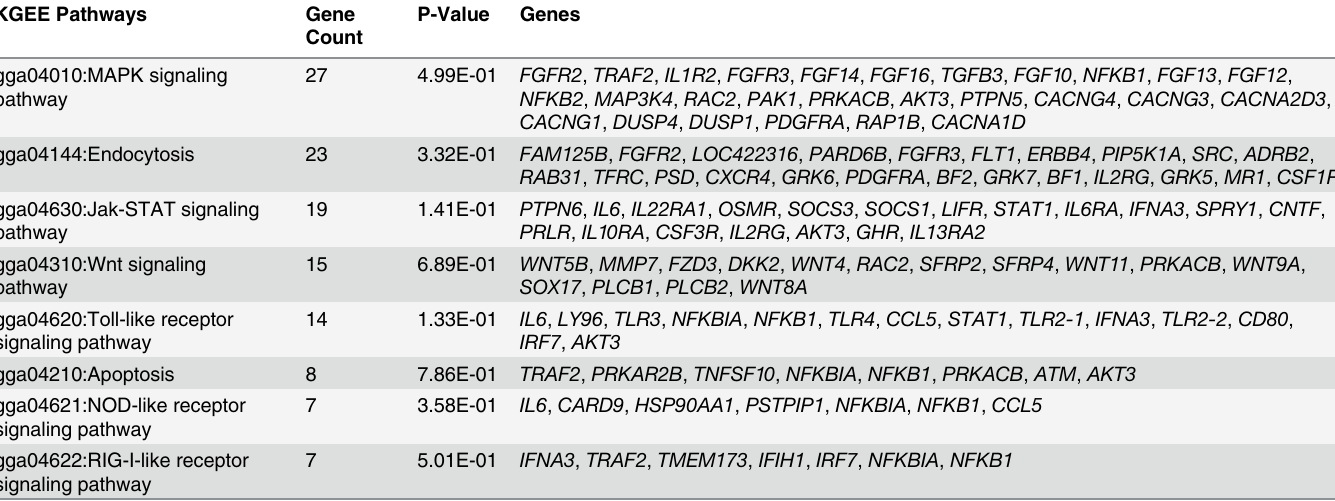
Table 4. Differentially expressed genes in REV infection involved in signalling pathways.